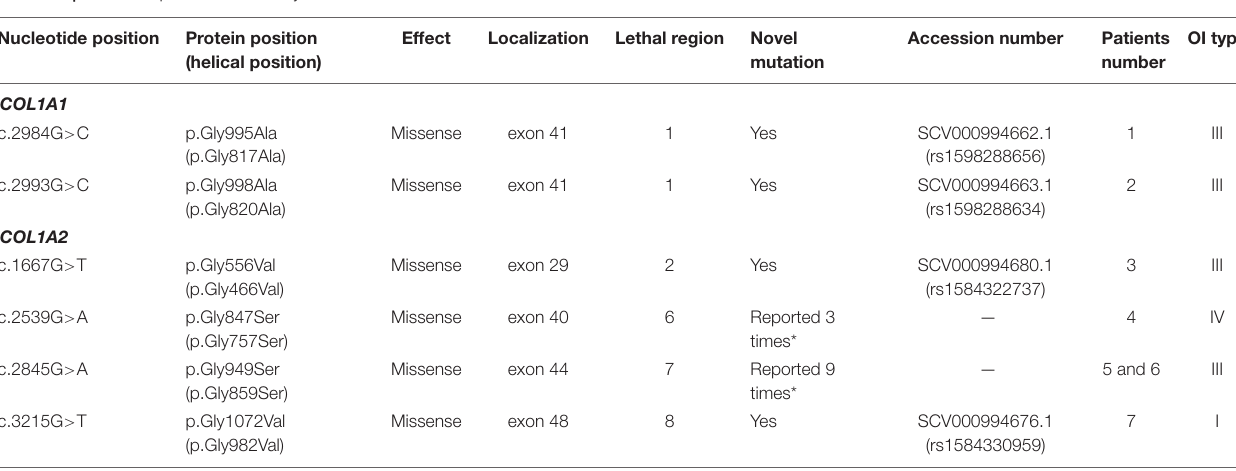
FIGURE 2 | Multiple Sequence Alignment analysis of novel variants across several species in Jalview 2.11.0, Clustal Omega 1.2.4. The conservation calculation is based on AMAS method of multiple sequence alignment analysis with identities scoring highest, and amino acids with substitutions in the same physico-chemical class have the next highest score. The score for each column is shown below the histogram. The conserved columns with a score of 11 are indicated by “*”. Columns with a score of 10 have mutations but all conserved properties are marked with a “+”. TABLE 2 | Variants reported in the